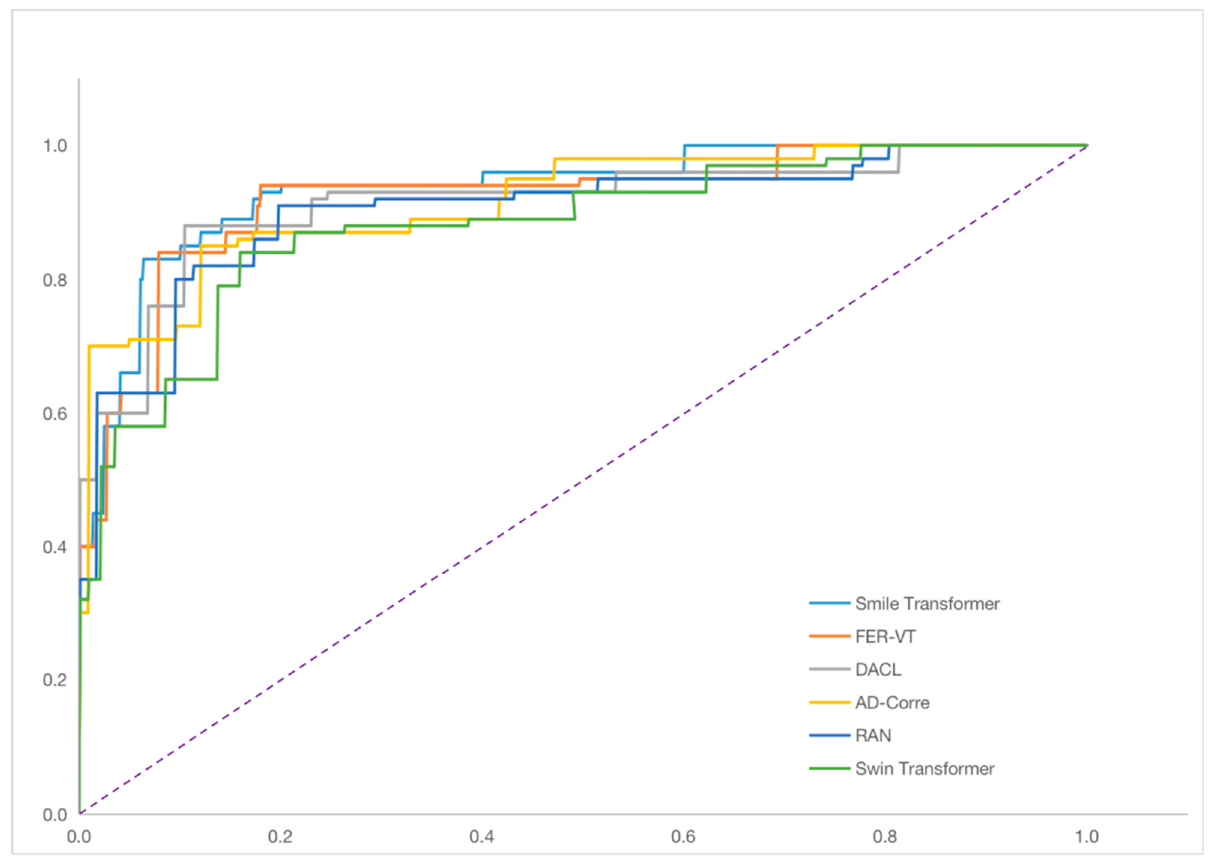
Figure 8. ROC curve of various methods.